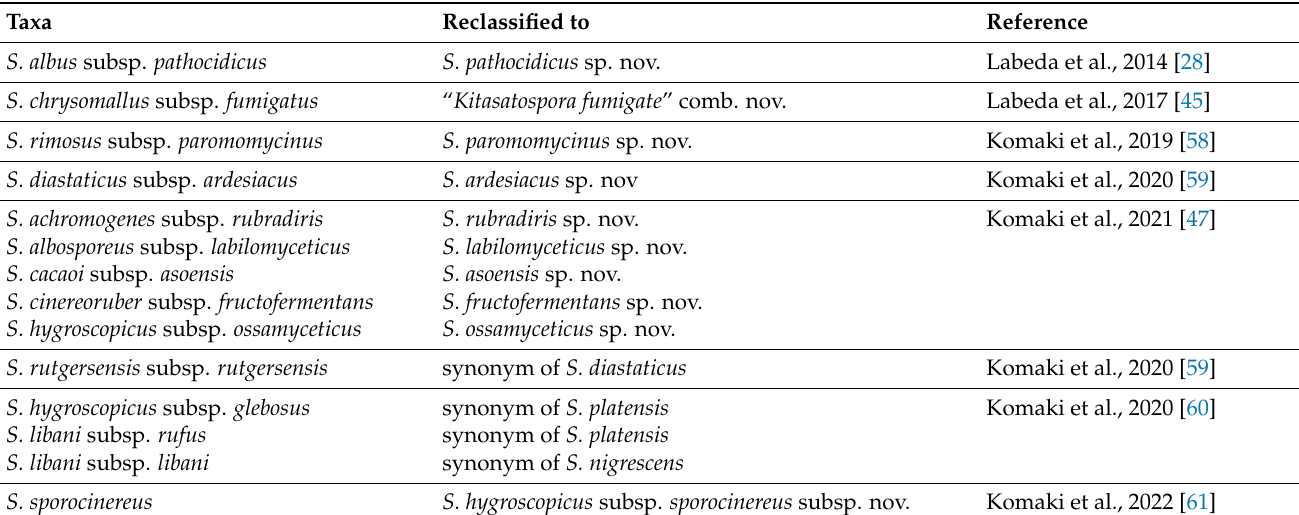
Table 2. Reclassification of subspecies in the genus Streptomyces